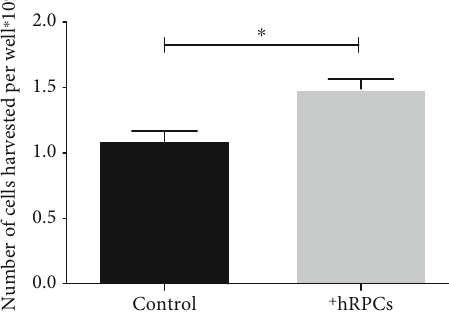
Figure 2: AMD cybrids cocultured with hRPCs show increased cellular viability. Using the Trypan blue dye exclusion assay, the cellular viability of AMD cybrids cocultured with hRPCs at 48 hr increased signi fi cantly ( p = 0 : 002 , n = 5 ) compared to AMD cybrids without hRPCs. Data of average numbers of live cells harvested from the treatment and control groups were compared to each other using an unpaired parametric t -test for a sample of n = 5